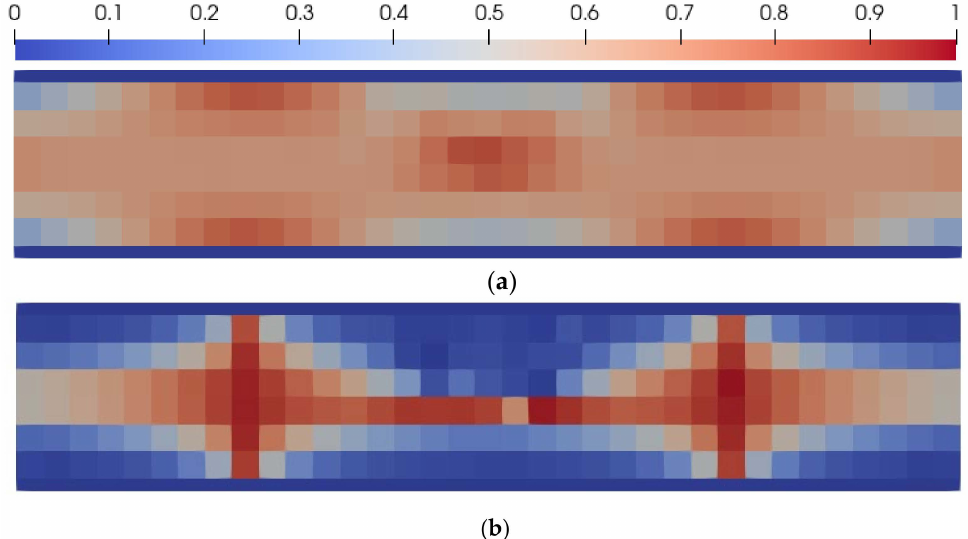
Figure 4. Distribution of porosity( a ) and ellipticity coefficient ( b